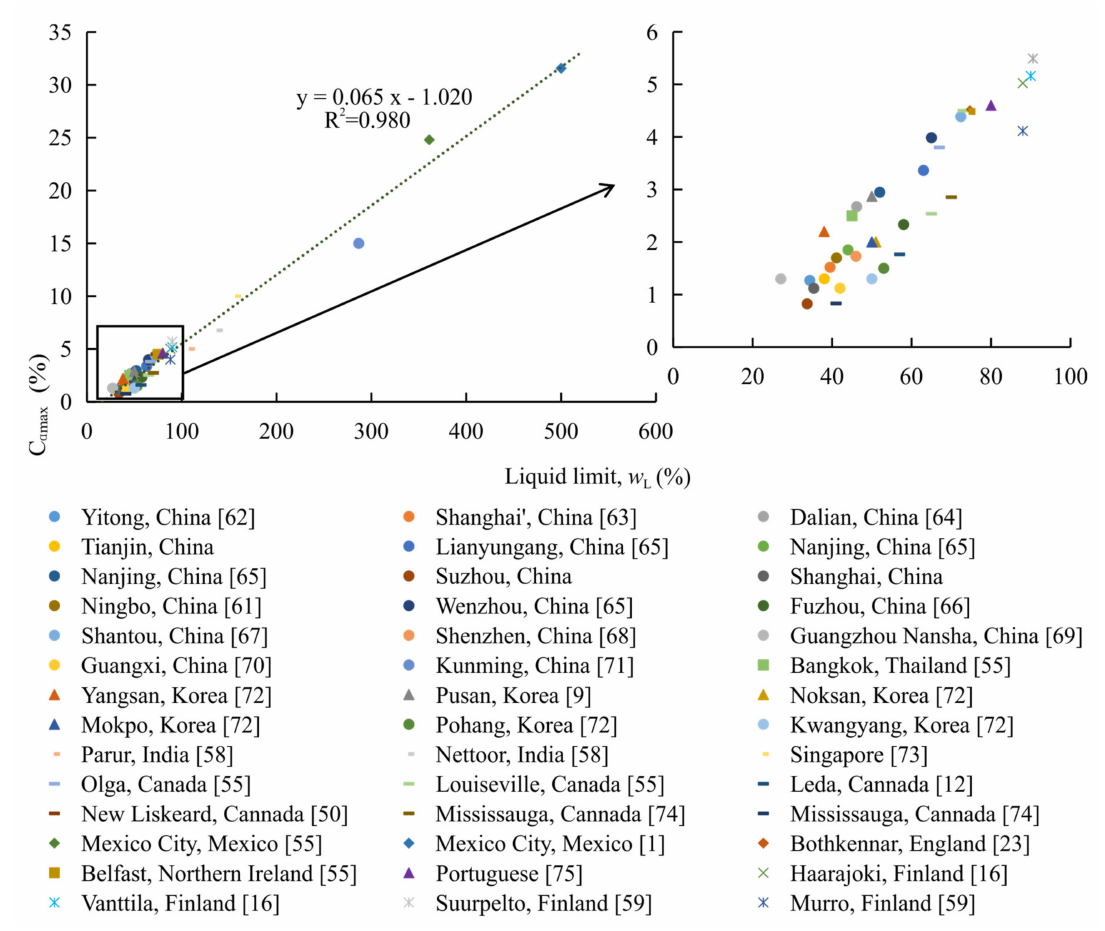
Figure 16. Relationship between C α max and w L